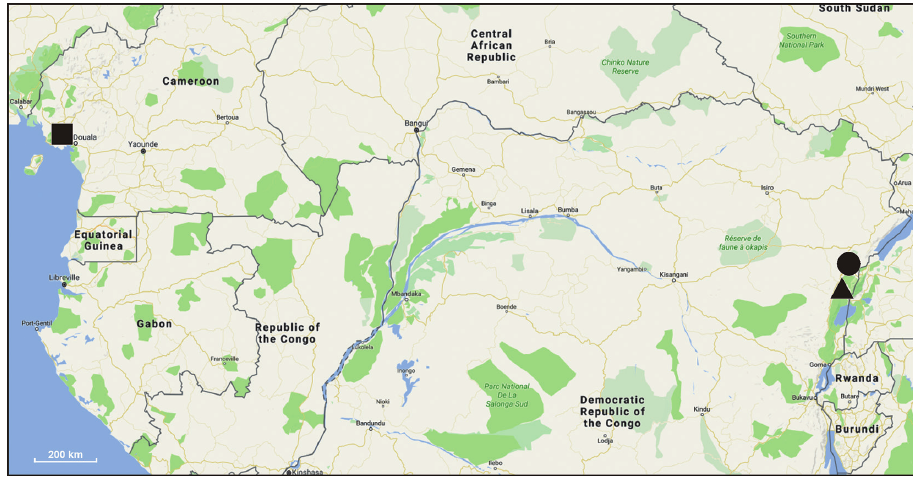
Figure 76. Distribution of Chedimanops gen. n. and Hybosidella gen. n. C . eskovi sp. n. (circle), C. rwen- zorensis sp. n. (triangle) and H . etinde sp. n. (square).